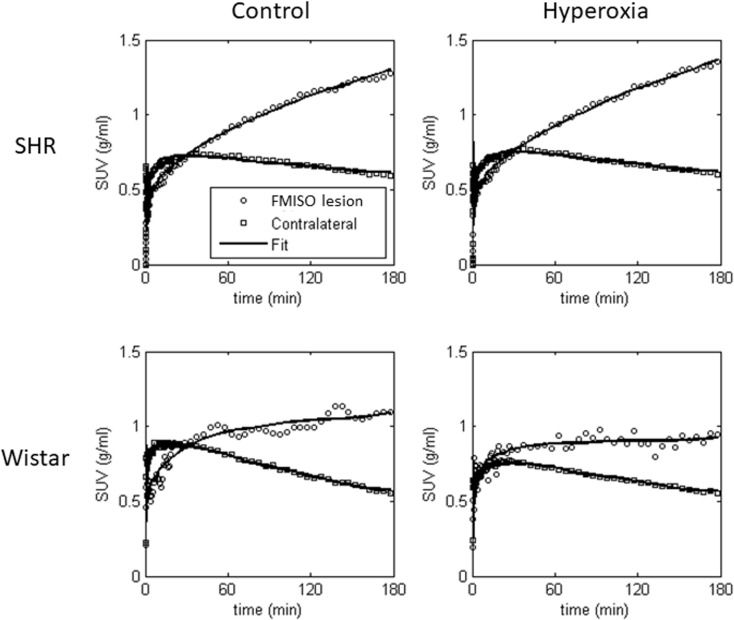
Representative FMISO time-activity curves for the FMISO hypoxic lesion ROI and contralateral ROI for the 3-hr PET scan, together with compartmental fits for SHR (top row) and Wistar (bottom row) rats under the control (left column) and hyperoxia conditions (right column).